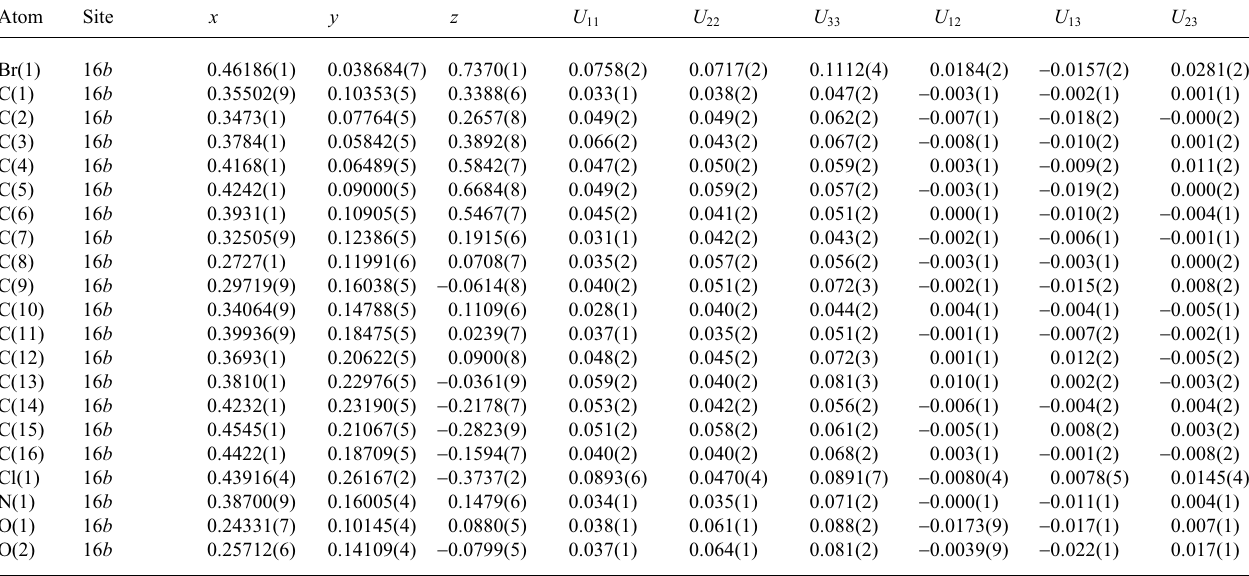
Table 3. Atomic coordinates and displacement parameters (in Å 2